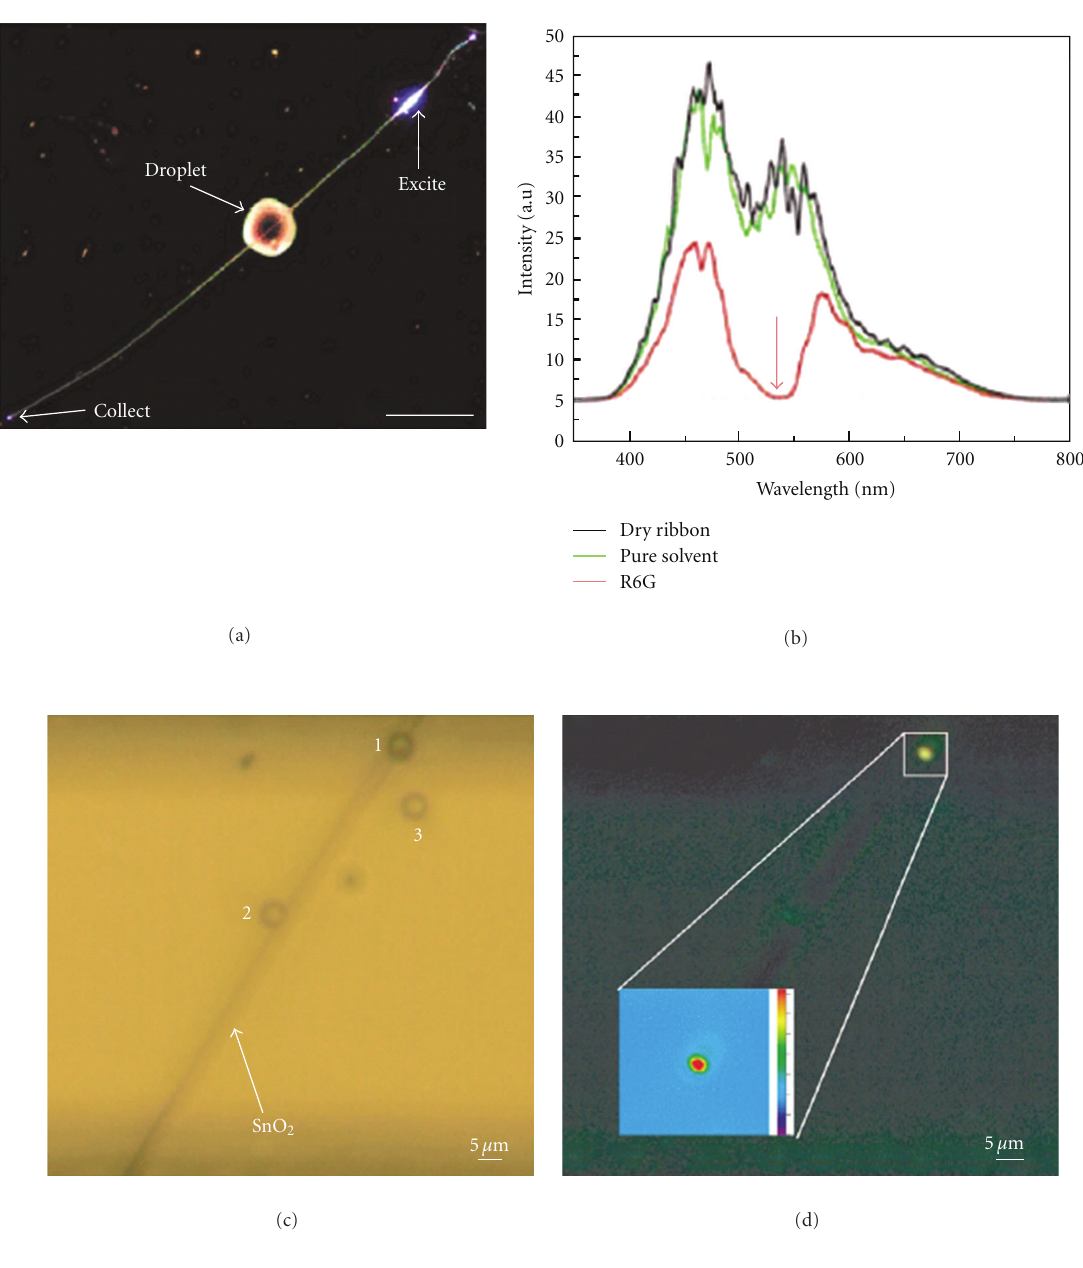
Figure 10: Demonstration of absorption and fluorescence schemes using individual SnO 2 nanoribbon waveguides. (a) Dark-field photoluminescence image of the absorption scheme showing an analyte centered in the middle of the ribbon and the labeled excitation and collection locations. (b) Spectra recorded after the SnO 2 defect emission traversed through the ribbon in air (black), pure glycol (green), and 1mM dye-loaded glycol (red). (c) Bright-field image of 2 μ m yellow-green fluorescent polystyrene beads placed with an optical trap precisely on or near a SnO 2 nanoribbon. (d) Fluorescence image of beads after waveguiding of photoluminescence from the SnO 2 ribbon. Inset: false color expansion of bead 1 during UV excitation of the